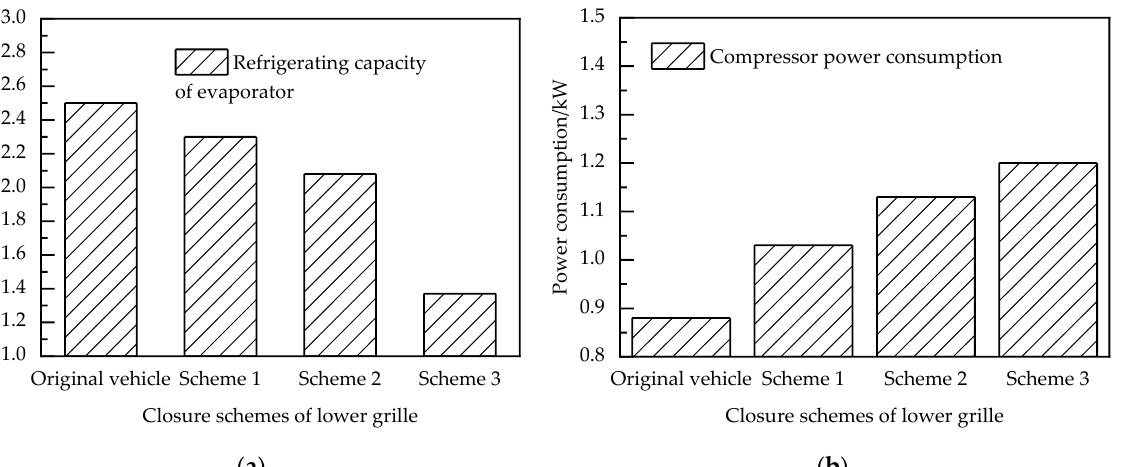
Figure 29. Comparisons of cooling capacity and power consumption of air conditioning system under different lower grille closure schemes: ( a ) comparison of refrigerating capacity; ( b ) comparison of power consumption.